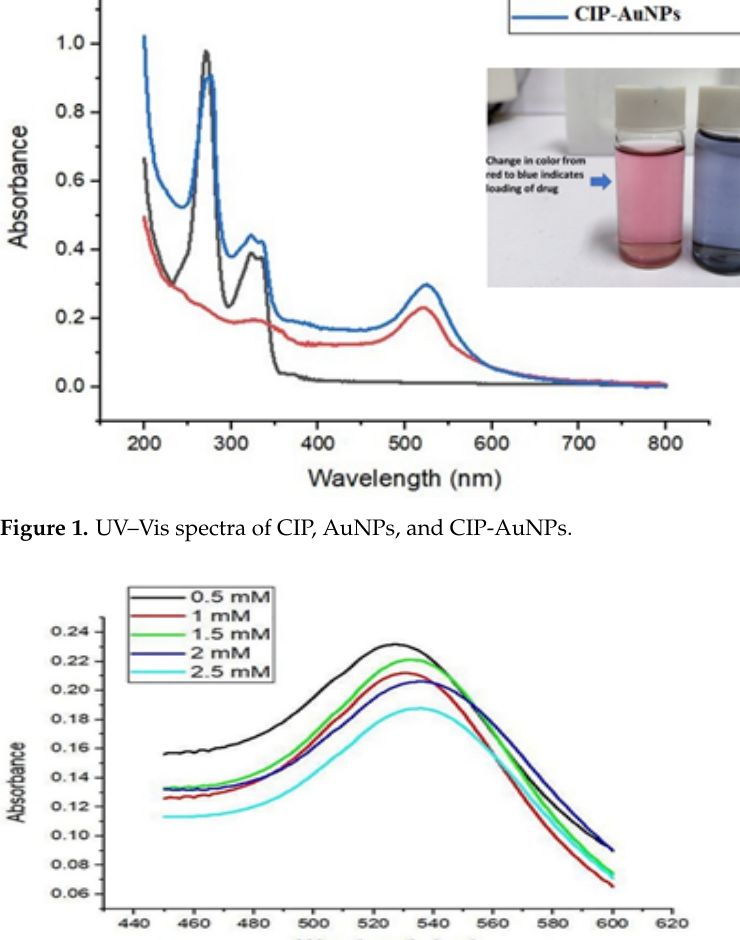
Figure 2. UV–Vis spectra of CIP-AuNPs loaded with various CIP concentrations.